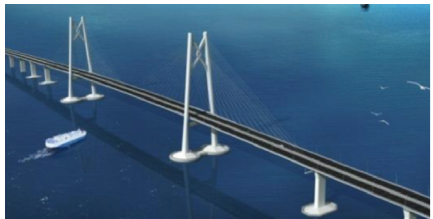
Figure 3: Qingzhou Shipping Channel Bridge.